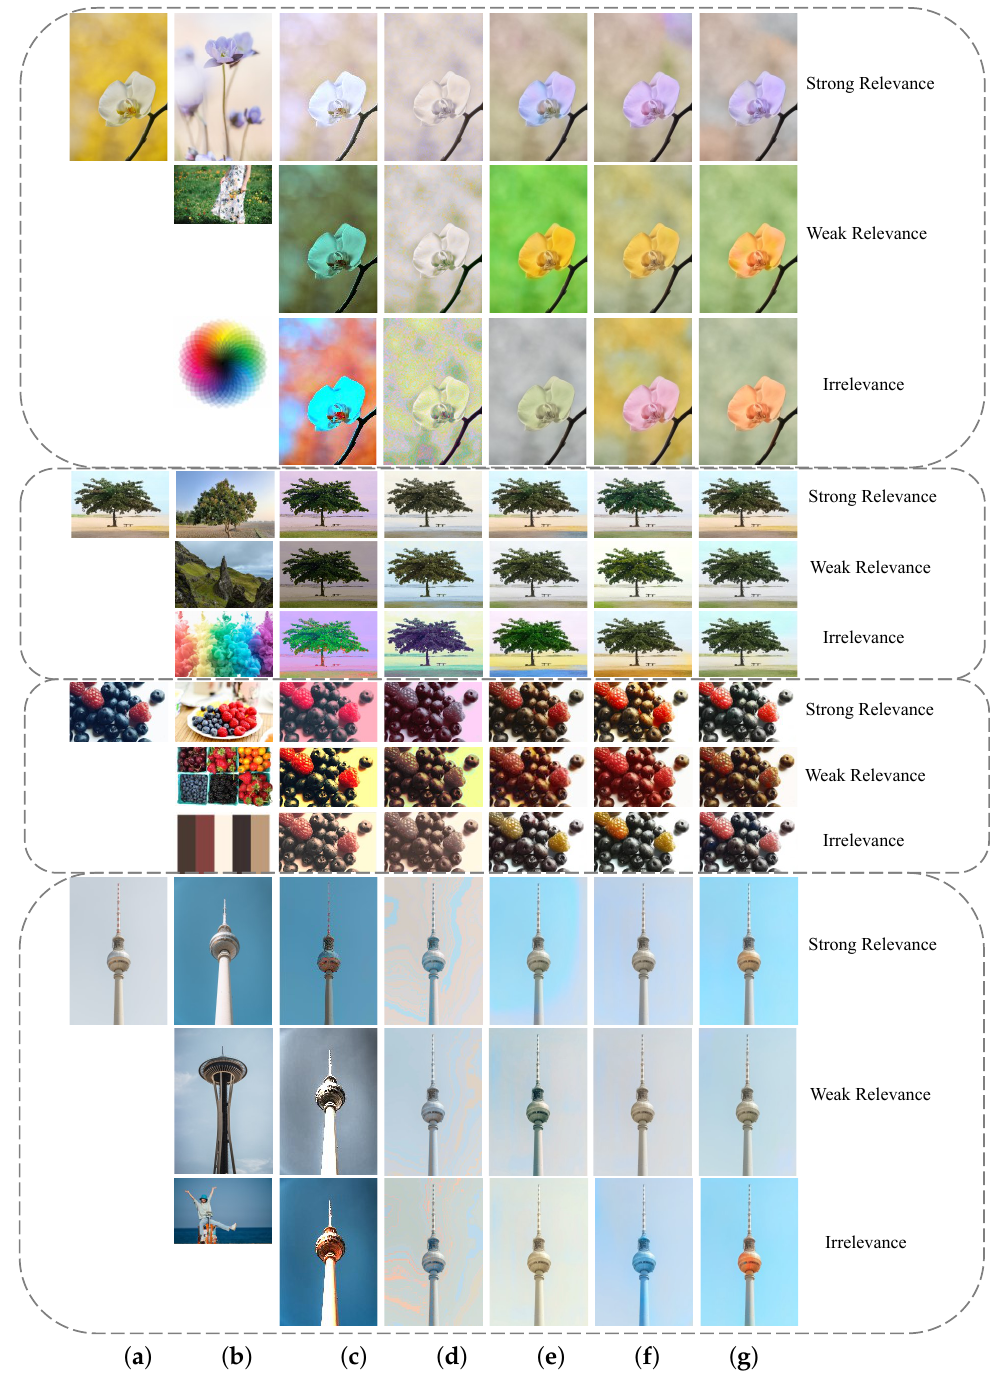
Figure 11. Qualitative results of an ablation study. There are a total of four groups of tests in the figure, and each group has three rows of images. The first, second, and third rows show color transfer results of image pairs of strong relevance, weak relevance, and irrelevance, respectively. The first column is the target image (TI), and the second column is the reference image(RI). ( a ) TI. ( b ) RI. ( c ) [1]. ( d ) [9]. ( e ) [18]. ( f ) [47]. ( g )